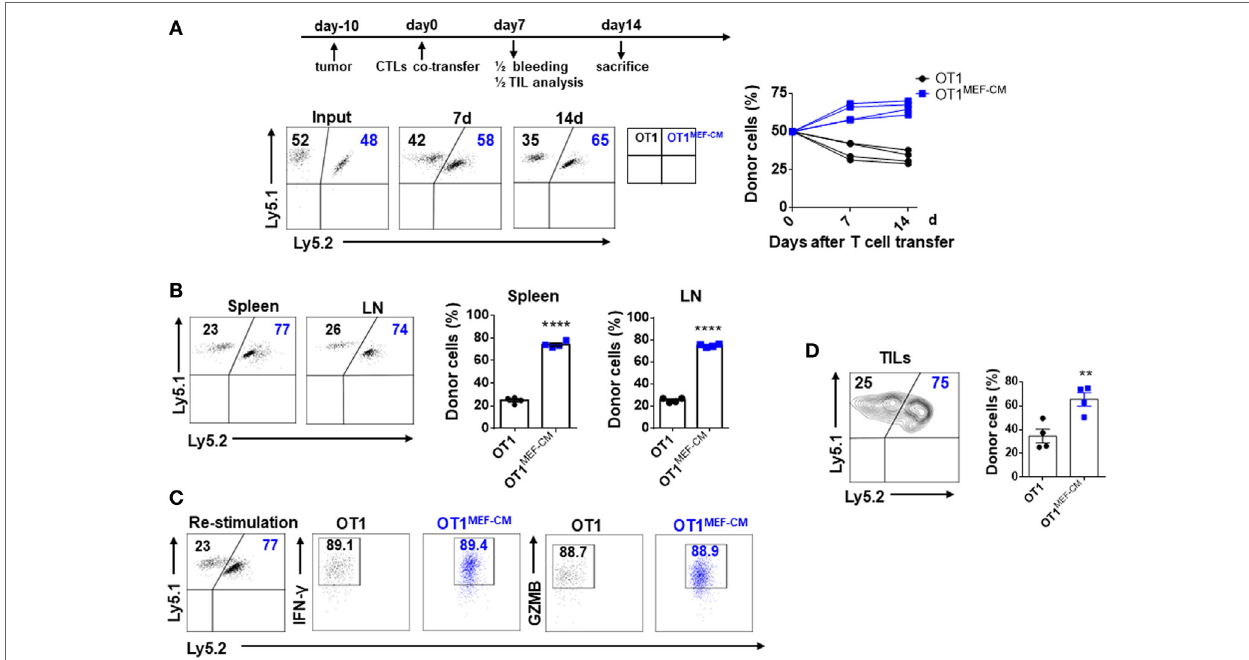
FigUre 6 | Mouse embryonic fibroblast-conditioned medium (MEF-CM)-educated cytotoxic T lymphocytes (CTLs) exert higher potential of persistence in tumor-bearing mice. Medium cultured Ly5.1 + / + OT-1 (0.75 × 10 6 ) and MEF-CM culture Ly5.1 + Ly5.2 + OT-1 (0.75 × 10 6 ) were co-transferred to tumor bearing (40–50 mm 3 ) Ly5.2 + / + B6 mice ( n = 8). The frequency of OT-1 cells were determined in peripheral blood (a) on days 7 and 14 of T cell transfer, and spleen and lymph node (B) on day 14 of T cell transfer. A representative fluorescence-activated cell sorting result showing percentages in plots indicate percent of donor cells among Ly5.1 + CD8 + T cells. Graphs are the summary of the dot plots on the left with each dot representing for a recipient ( n = 4). (c) Whole splenocytes were restimulated with OVA 257–264 peptides for 2 days in vitro , interferon-gamma, and granzyme B-producing levels were examined. (D) Transferred cells in the tumors were analyzed after 7 days of T cell transfer. Half of the recipients ( n = 4) were analyzed for panels (a–c) and the remaining were analyzed for panel (D) . Statistical significance was analyzed by unpaired t -test (** P ≤ 0.01; **** P ≤ 0.0001). Two independent biological experiments were proceeded with similar